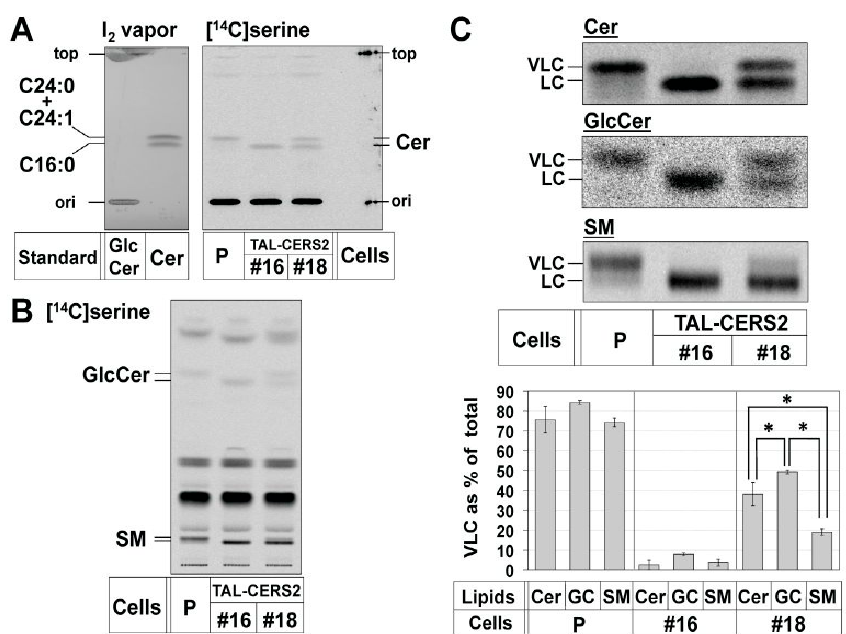
Figure 3. Different fatty acid preferences of GlcCer and SM. ( A , B ) Metabolic labeling of sphingolipids with radioactive serine for a short time. Cells were cultured with [ 14 C]serine for 2 h, and lipids extracted from the cells were separated by TLC. ( A ) Separation between upper (VLC-containing) and lower (LC-containing) bands of ceramide by normal-phase TLC (Method 3 described in the “Experimental Section”). Non-radiolabeled ceramide standards (C16:0, C24:1, and C24:0) were developed simultaneously and visualized by iodine vapor. The positions of the spot origin (ori) and the solvent front (top) in two images were aligned; ( B ) separation of upper and lower bands of GlcCer and SM by normal-phase TLC according to Method 1. Radioactive images of analyzed TLC plates are shown. The darker image is shown in Figure S6B; ( C ) comparison of the proportion of upper band intensities (indicating the proportion of VLC) of ceramide, GlcCer, and SM shown in ( A , B ). The enlarged and darker images of [ 14 C]serine-labeled ceramide, GlcCer, and SM shown in ( A , B ) are aligned. The proportions of VLC-containing lipids are expressed as described in Figure 2B: mean percentage ± SD obtained from three independent experiments. The Bonferroni corrected Student’s t -test was used for multiple comparisons. * p < 0.017.